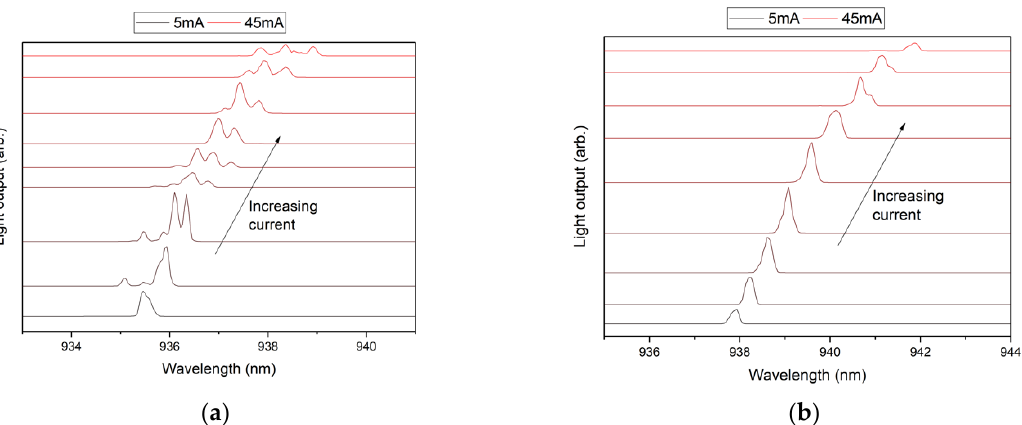
Figure 9. Emission spectra taken at 5 mA intervals above threshold current for ( a ) a 26 𝜇 m diameter unoxidised unlapped QF VCSEL and ( b ) a 26 𝜇 m diameter unoxidised lapped QF VCSEL, showing mode-hopping in the unlapped device as injection current is increased.